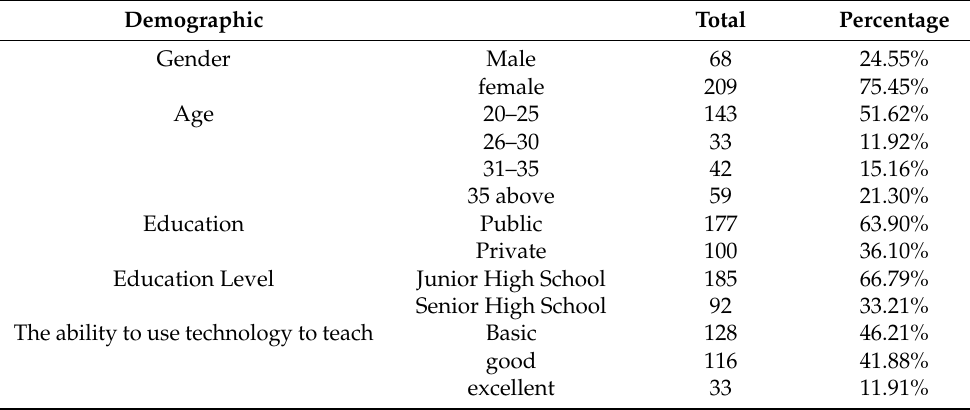
Table 1. Demographic data of